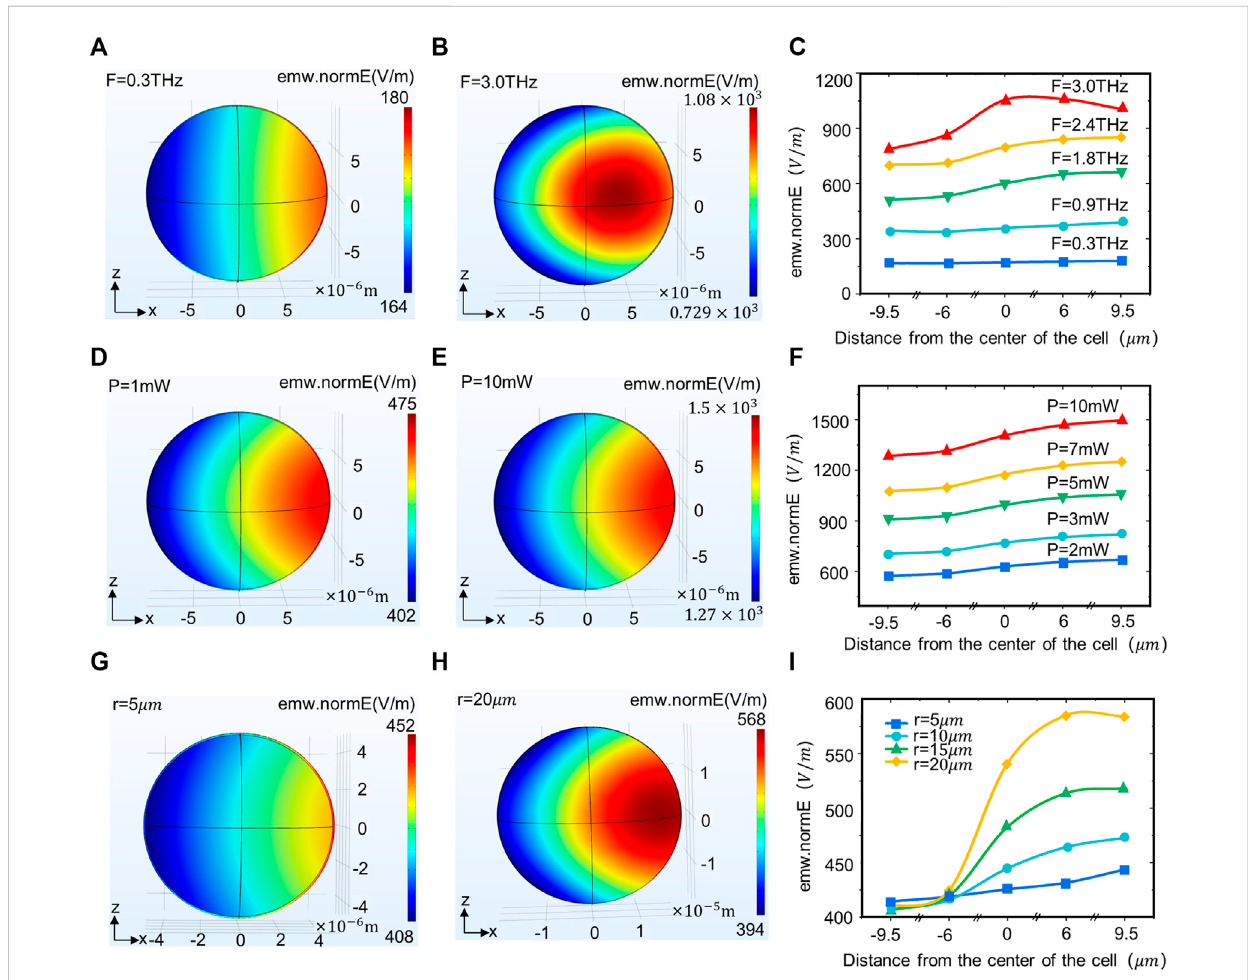
FIGURE 2 Terahertzwavepropagationinneuronswithdifferentterahertzradiationparametersandneuronsize. (A,B) Propagationlawofterahertzwaveswith frequenciesof0.3and3 THzintheXZplaneofneurons. (C) Propagationlawofterahertzwaveswithdifferentpowersinneurons(simulationtime:steady state,initialtemperature:293.0 k,r=10 um,F=0.3,0.9,1.8,2.4,3.0 THz, p =1 mW). (D , E) PropagationlawofterahertzwaveswithPowerof1and10 mW intheXZplaneofneurons. (F) Propagationlawofterahertzwaveswithdifferentpowersinneurons(simulationtime:Steadystate,initialtemperature: 293.0 k, r = 10 um, F= 1.2 THz, p = 2, 3, 5, 7, 10 mW). (G, H) The propagation law of terahertz waves in different neuron sizes (radii 5 and 10 um) in the XZ plane. (I) Propagation law of terahertz waves in neurons of different sizes (simulation time: Steady state, initial temperature: 293.0 k, r = 5, 10, 15, 20 um, F = 1.2 THz, p = 1